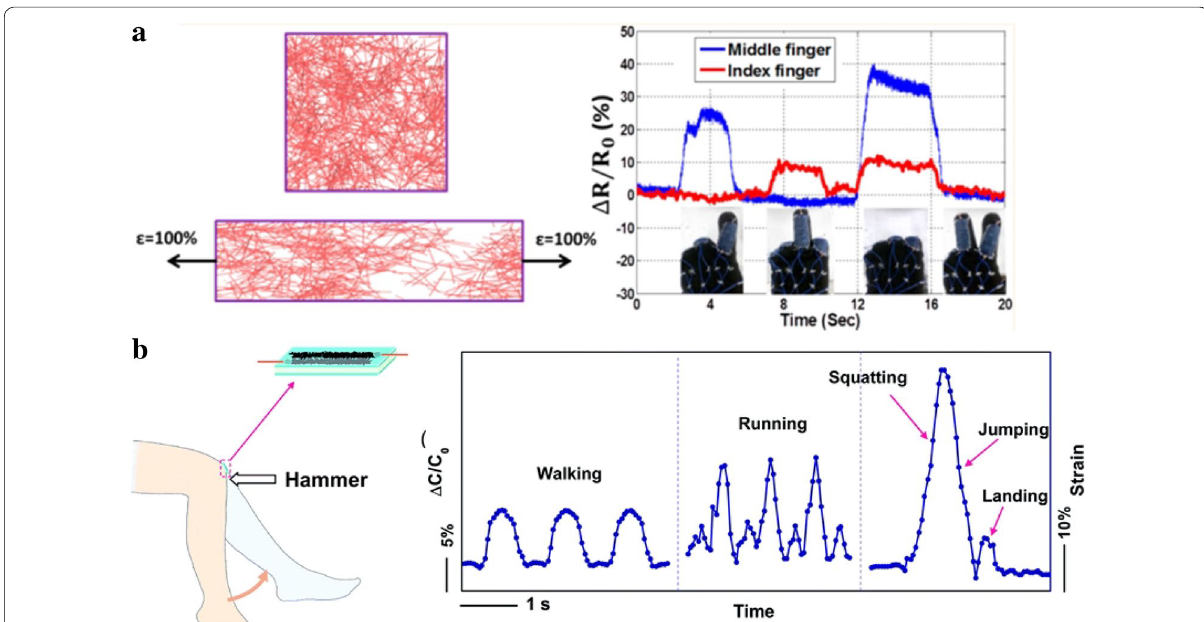
Fig. 6 a Percolation dependent resistive type strain sensor. Disconnection of the AgNWs networks under strain (left), and relative resistance change under different finger motion (right). Reproduced with permission [59]. Copyright 2014, America Chemical society. b Relative capacitance change and strain as a function of time during diverse human motions of walking, running, squatting, and jumping by mounting strain sensor onto the knee. Reproduced with permission [44]. Copyright 2014, Royal Society of